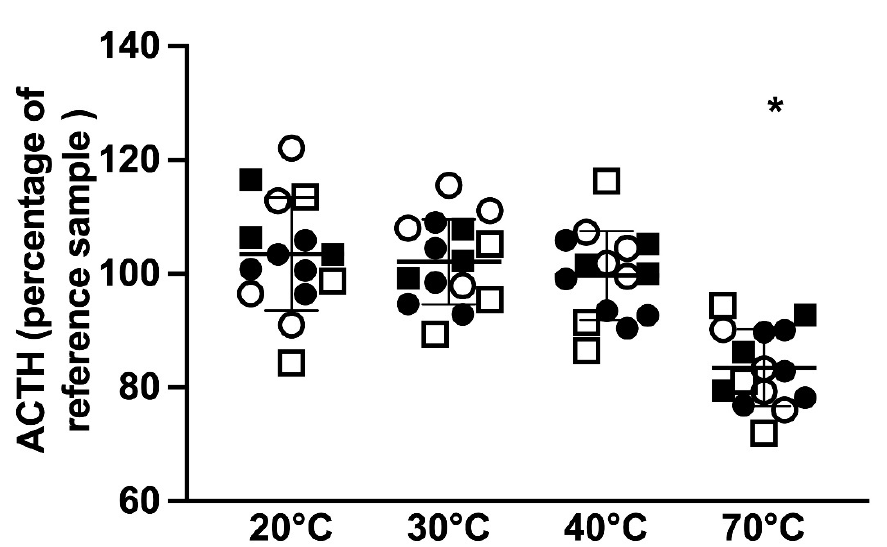
Figure 3. ACTH concentrations presented as a percentage of the reference sample in samples kept at 4 (reference sample), 20, 30, 40, and 70 °C in 15 horses (mean ± standard deviation). Squares represent horses in which the basal ACTH concentration was determined and circles indicate horses in which the post-TRH stimulation ACTH concentration was determined. Hollow shapes represent non-PPID horses and solid shapes indicate horses with PPID. * p < 0.05 vs. 4 °C.